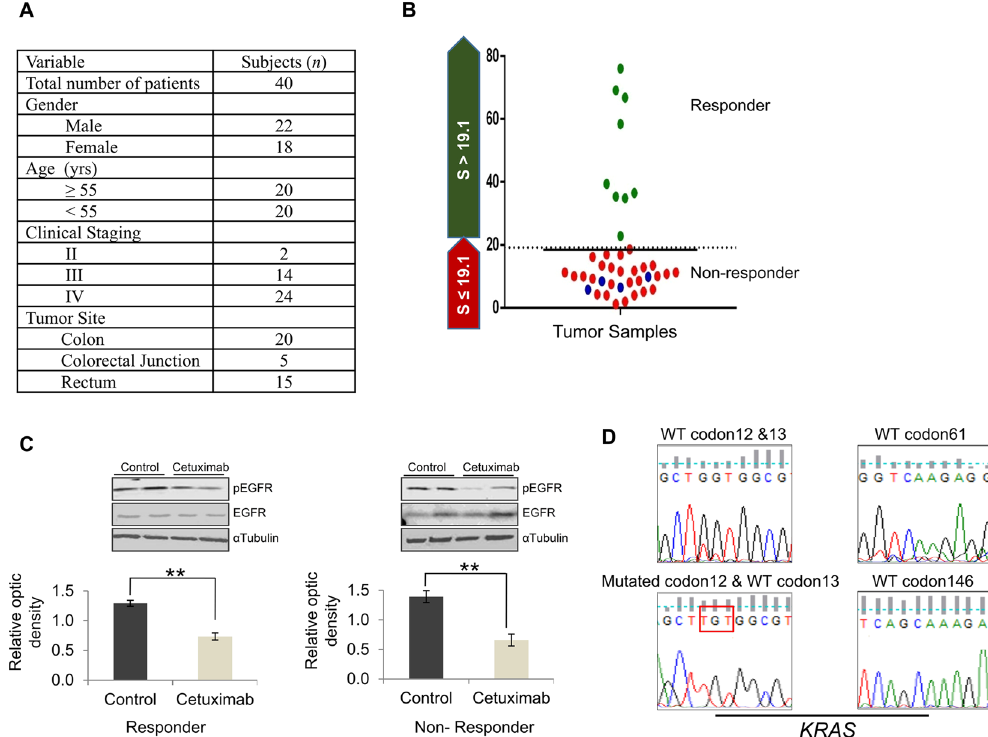
Figure 1. Patient derived CRC explants with wt KRAS exhibit differential sensitivity to anti-EGFR agent. ( A ) Demographic details of mCRC patients enrolled for the study. ( B ) Scatter plot depicting S-Score for responders (green) and non-responders (red, KRAS wild-type and blue, KRAS mutated) to cetuximab ( n = 40). Samples with S-Score greater than 19.1 were categorized as responders. ( C ) Total protein was isolated from the responder (left) and non-responder (right) tumor samples to cetuximab, separated using SDS-PAGE, blotted on PVDF membrane and incubated with antibody against phospho-EGFR (175kDa). Membranes were re-probed with total EGFR and α Tubulin (loading control) respectively. Densitometric analysis for pEGFR was carried out and plotted after normalizing against the loading control. ** P < 0.01 was calculated using ANOVA. ( D ) Representative chromatograms depicting wt KRAS (codon 12/13, 61 and 146) and mutated KRAS (codon 12; red